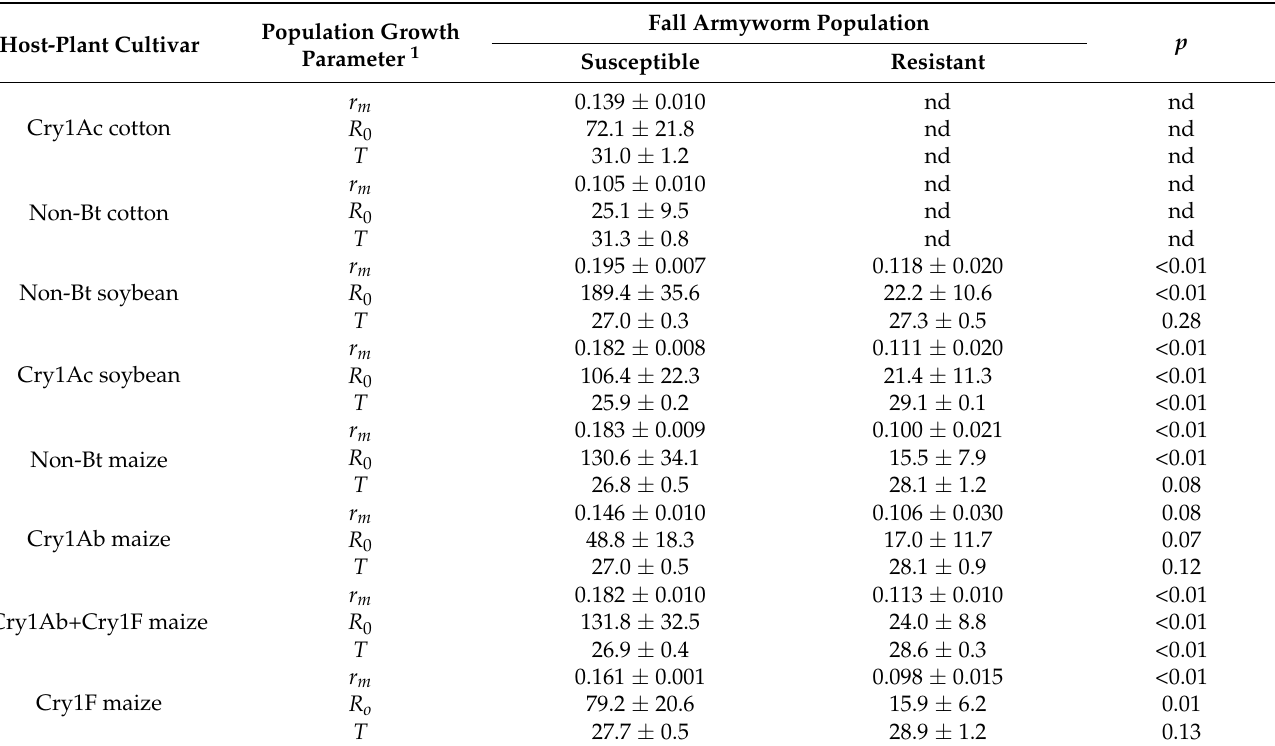
Table 2. Fitness costs of fall armyworm resistance to dual-gene Bt maize (Cry1A.105+Cry2Ab2). Shown are population growth statistics for Bt-resistant and -susceptible fall armyworms reared on the foliage of eight host-plant cultivars ( n = 12–17 families per insect population per host-plant cultivar).